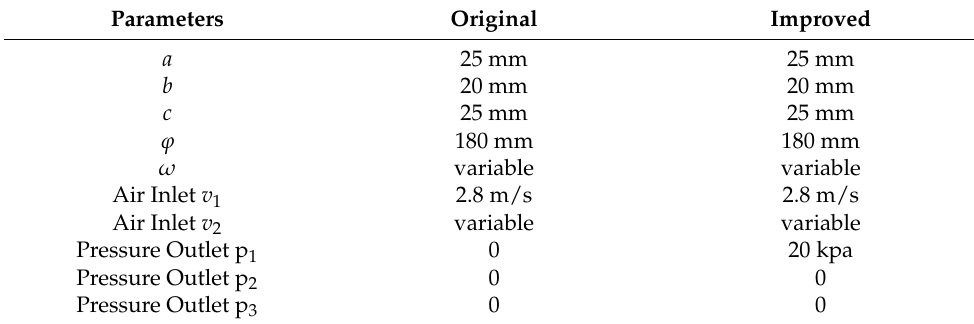
Figure 2. Two-dimensional simulation geometric models of original ( a ) and improved ( b ) pneumatic drum magnetic separator. Table 1. Parameters used in the simulation.